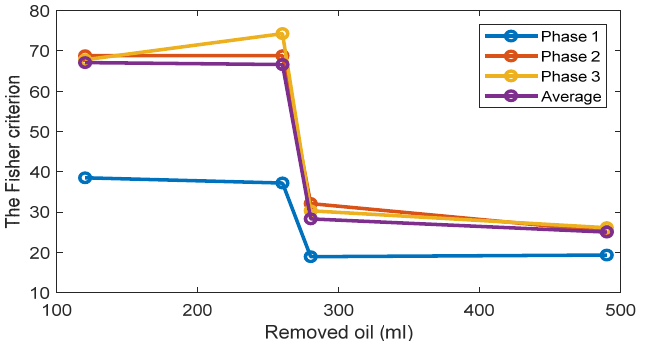
Figure 5. The FC of Feature 1 (the first harmonic of the supply frequency) for three phases and 4 levels of oil removal compared to the standard oil level (Day 1).